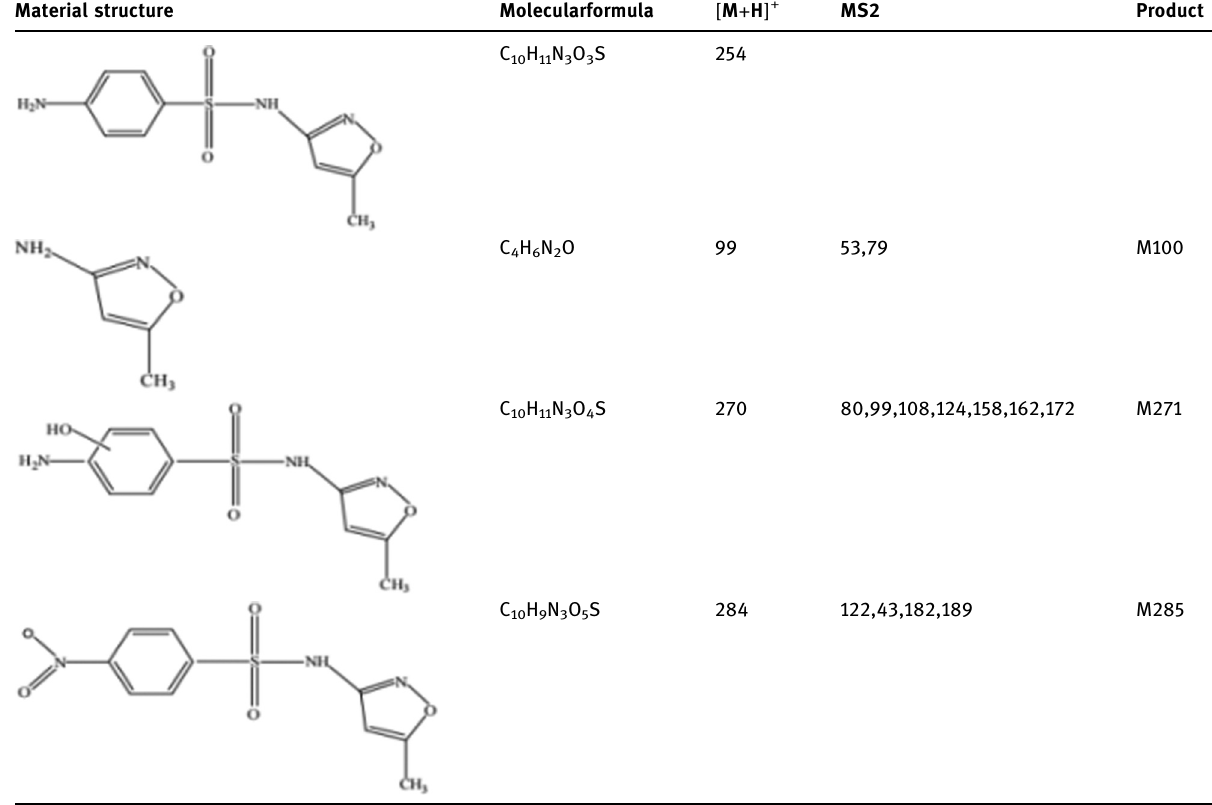
Table 3: Molecular structure formula and mass spectrum fragment ion distribution of intermediates Material